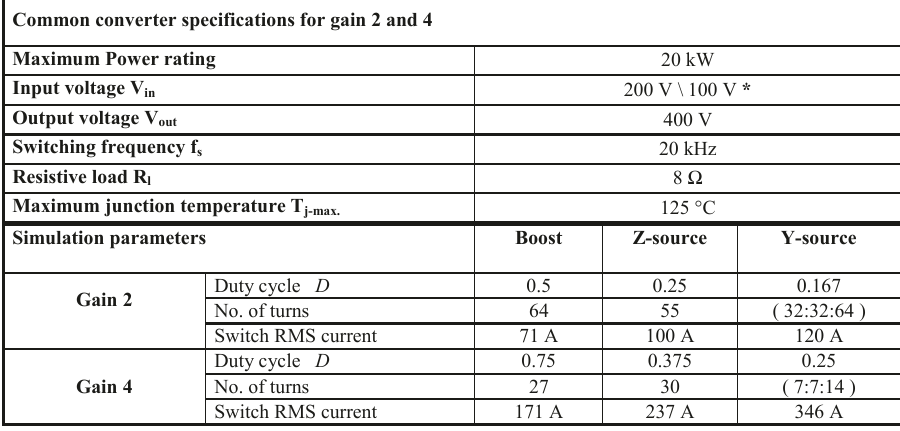
(cid:27)(cid:3)(cid:159)